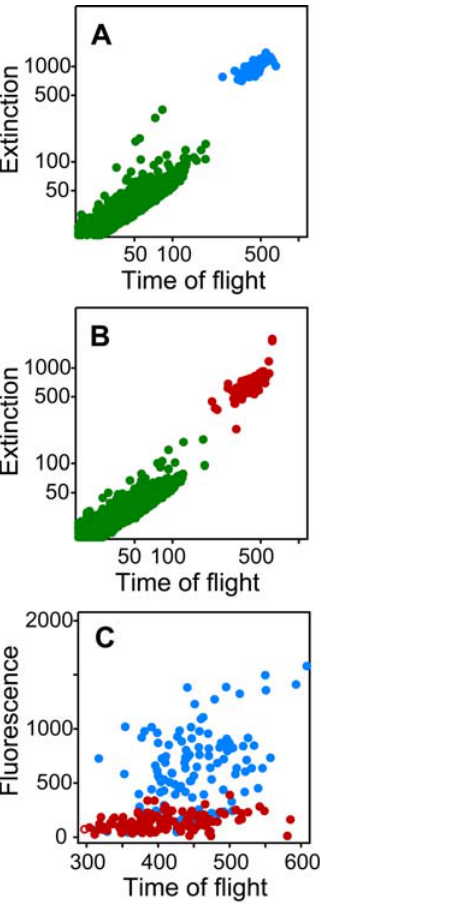
Figure 1. Separation of adult C.elegans from their offspring and corresponding adult feeding. Extinction (optical density; log 10 scale) versus time of flight (length; log 10 scale) for ( panel A ) wild-type and ( panel B ) eat-2(ad465) nematodes, showing the results of the clustering algorithm to separate either wild-type ( blue) or eat-2 ( red) adults from larvae ( green ). In panel C the relationship between fluorescence (accumulated microspheres) versus time of flight for the adult wild- type ( blue ) and eat-2 ( red ) nematodes is shown. Each point corresponds to a single nematode.